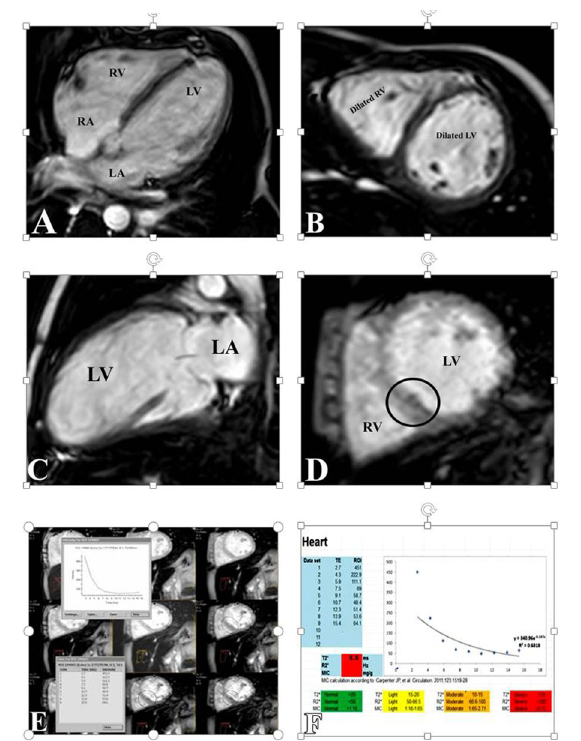
Fig. 8 Dilated form of infiltrative cardiomyopathy secondary to iron overload. Ten-year-old male with thalassemia major presented with signs of heart failure. Short axis and long axis in four- and two- chamber cine images ( a , b , and c , respectively) showing marked dilation of both ventricles (LVEDV = 121.6 ml and RVEDV = 140 ml) with global hypokinesia and reduced LVEF (20%) and RVEF (39%). Short axis gradient-echo imaging sequence ( d ) show decreased myocardial signal more in infero-septal segment (circle in d ). T2* WI ( e ) shows myocardial iron overload of heart together with decay curve in excel sheet ( f ). Both show heavy iron overload in heart and rapid signal loss with (T2* value = 8.8